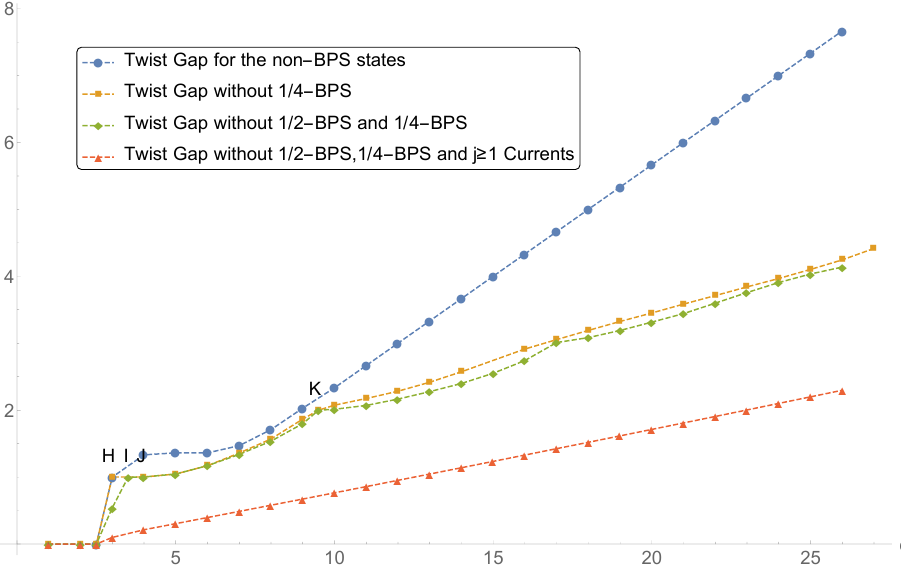
Figure 10 . Numerical upper bounds on the twist gap for the N = 2 SCFTs under various assumptions. The blue line represents the most generic bounds for the N = (2 ; 2)